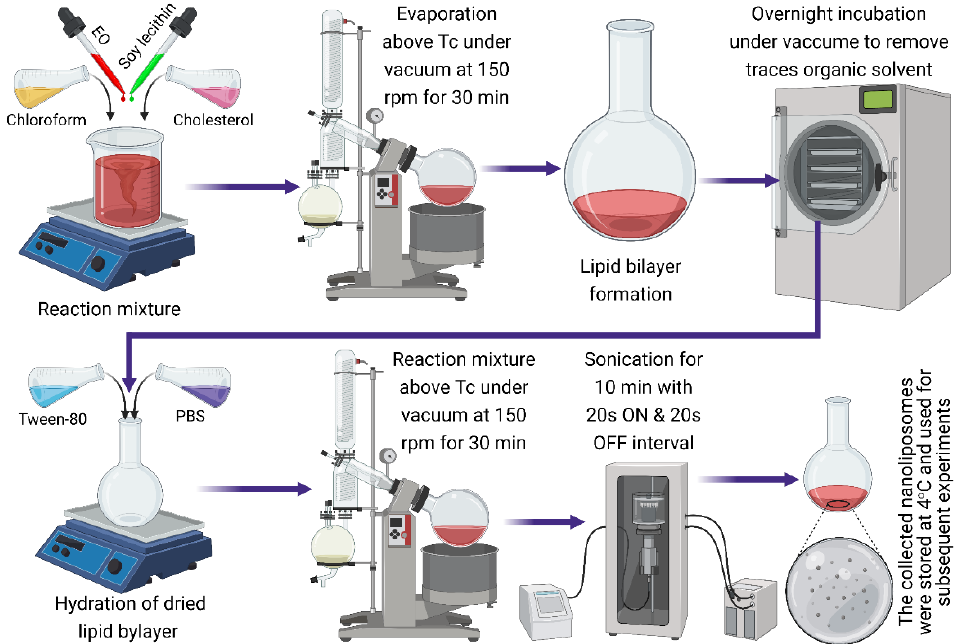
Figure 5. Illustration of as used thin-film hydration–sonication procedure to fabricate EO (CEO/TTO)-loaded nanoliposomes. Created with BioRender.com and extracted under premium membership.